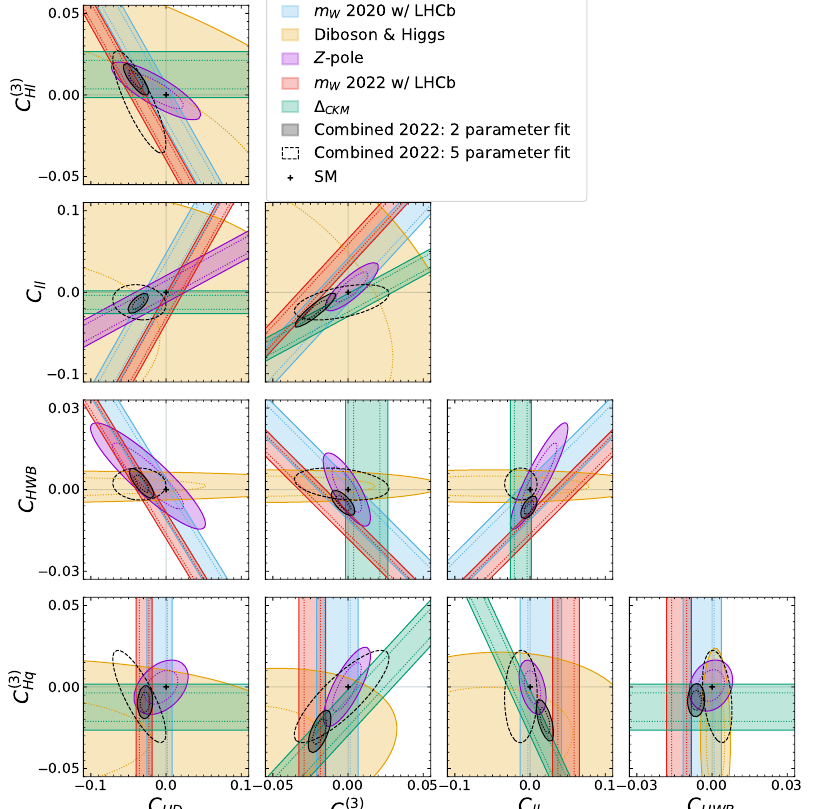
Figure 8 . Planes of pairs of coefficients of operators that can affect m W and ∆ CKM , showing the constraints from direct m W measurements before (blue) and after (red) the recent CDF update, Z -pole data (purple), diboson and Higgs data (beige), and ∆ CKM (green). The combined constraints are given by solid and dashed dotted lines for a 2- and 5-parameter fit